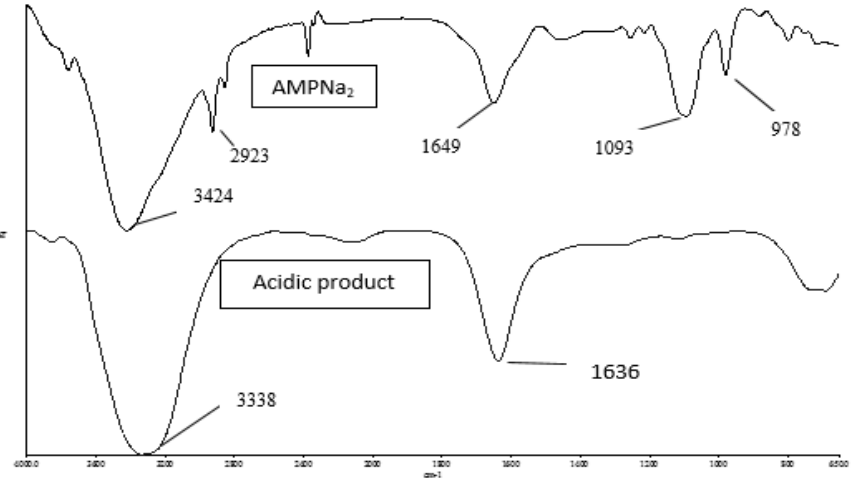
and product of acidic hydrolysis of 0.0001 M AMPNa 2